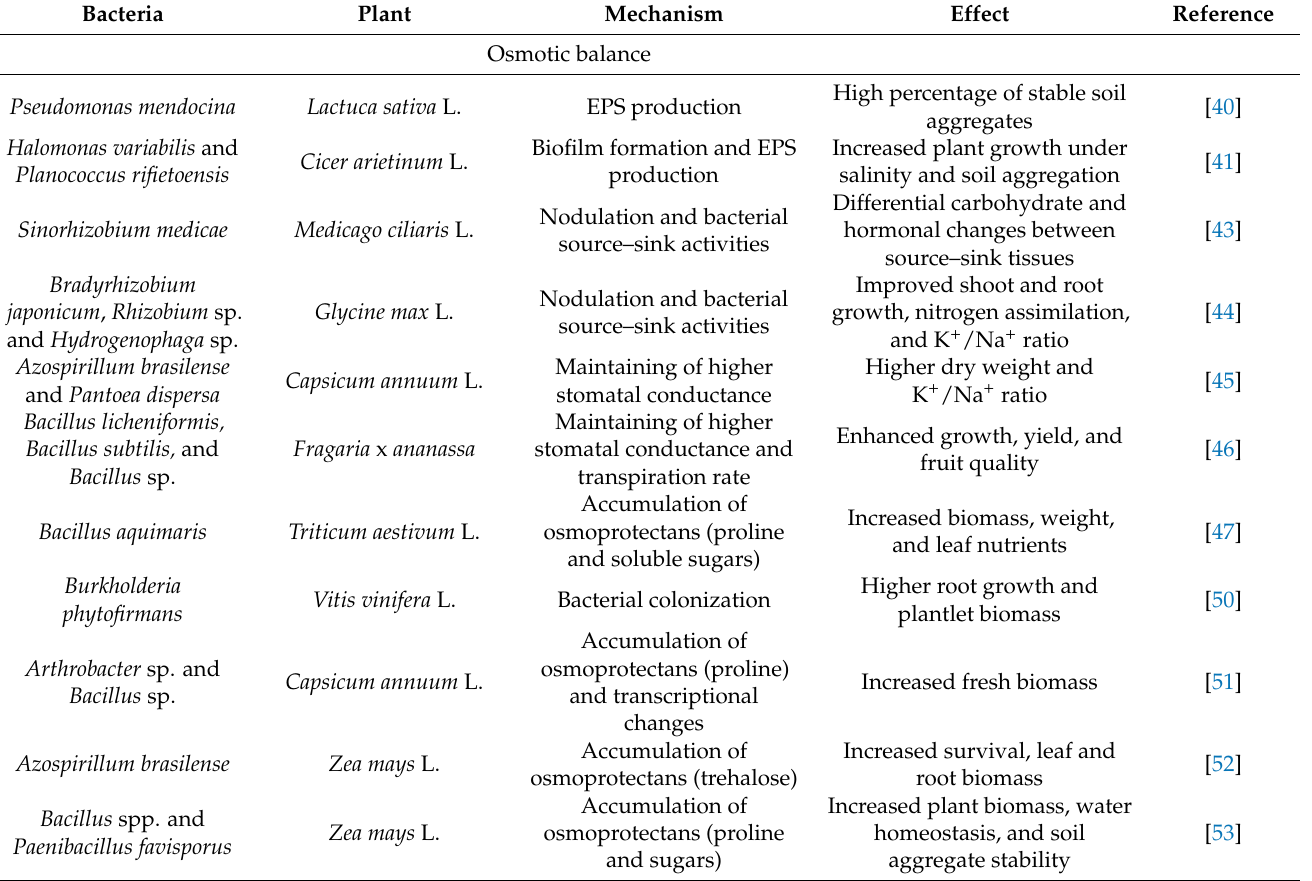
Table 1. PGPB-produced mechanisms related to tolerance against salinity